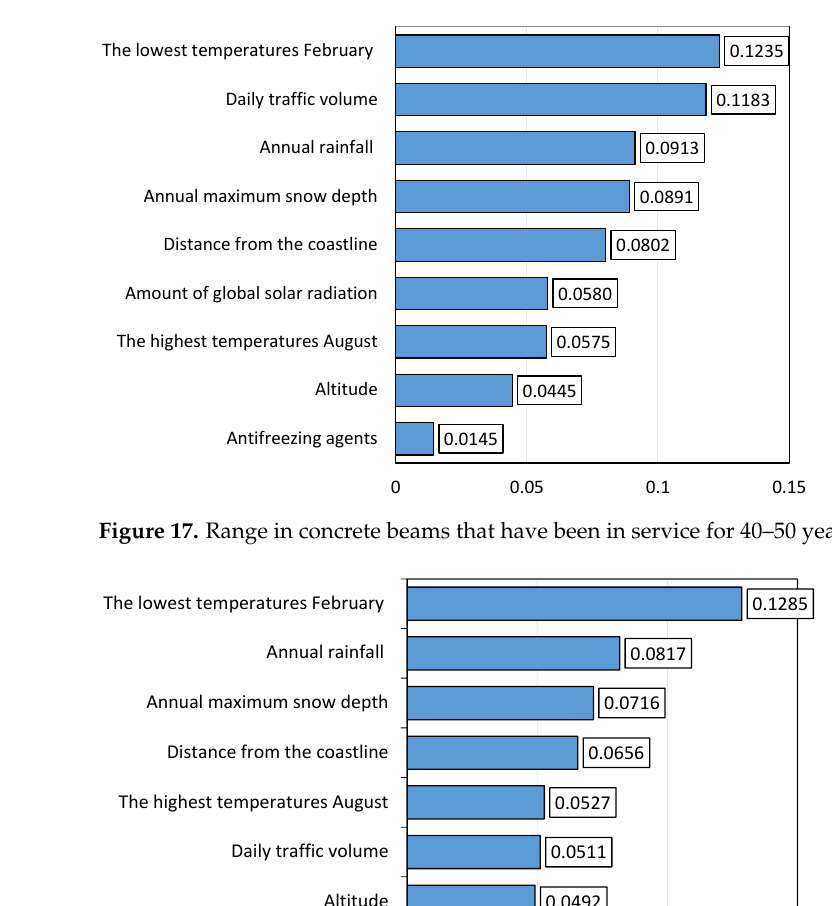
Figure 16. Range in concrete beams that have been in service for 30 – 40 years.